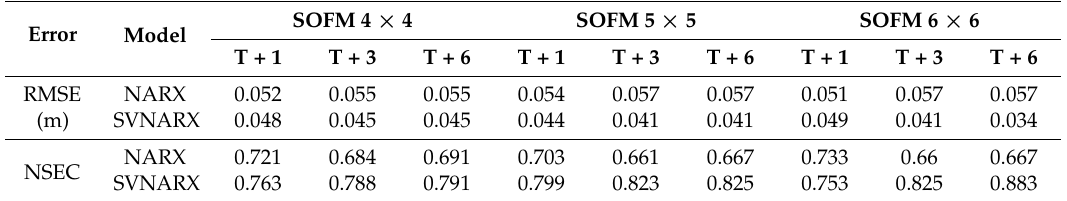
Table 4 . Inundation predictions for various SOFM dimensions. Table 4. Inundation predictions for various SOFM